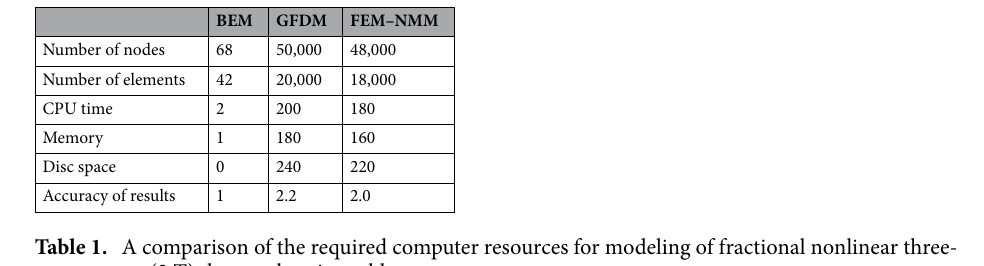
Table 1. A comparison of the required computer resources for modeling of fractional nonlinear three- temperature (3 T) thermoelectric problems.